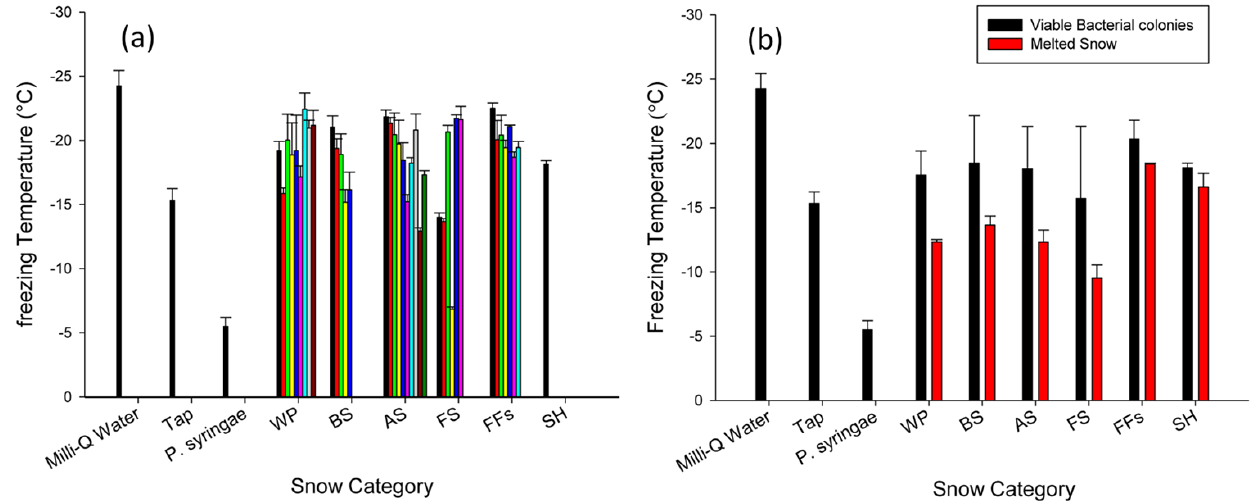
Figure 4. Ice nucleation activity of viable cultivable bacteria in Arctic samples. The average ice nucleation temperature of: (a) individual bacterial isolates and (b) total bacterial isolates and melted Arctic samples. Arctic snow categories: accumulated snow (AS), blowing snow (BS), fresh snow (FS), surface hoar snow (SH), windpack (WP), and frost flowers (FFs). Controls: ultrapure water (Milli-Q-water), tap water, and a suspension of laboratory-grown Pseudomonas syringae ( P. syringae ). Error bars indicate standard deviation (SD) of the mean for three